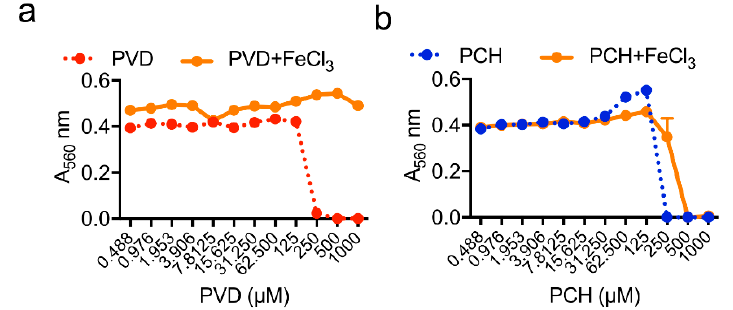
Figure 4. Pyoverdine (PVD) ( a ) and pyochelin (PCH) ( b ) activities on A. fumigatus growth in MM in presence of iron excess, showing that the antifungal effect of pyoverdine on A. fumigatus was abolished in presence of iron excess, whereas pyochelin antifungal activity was not abolished. Methodology is described in Supplementary Materials.